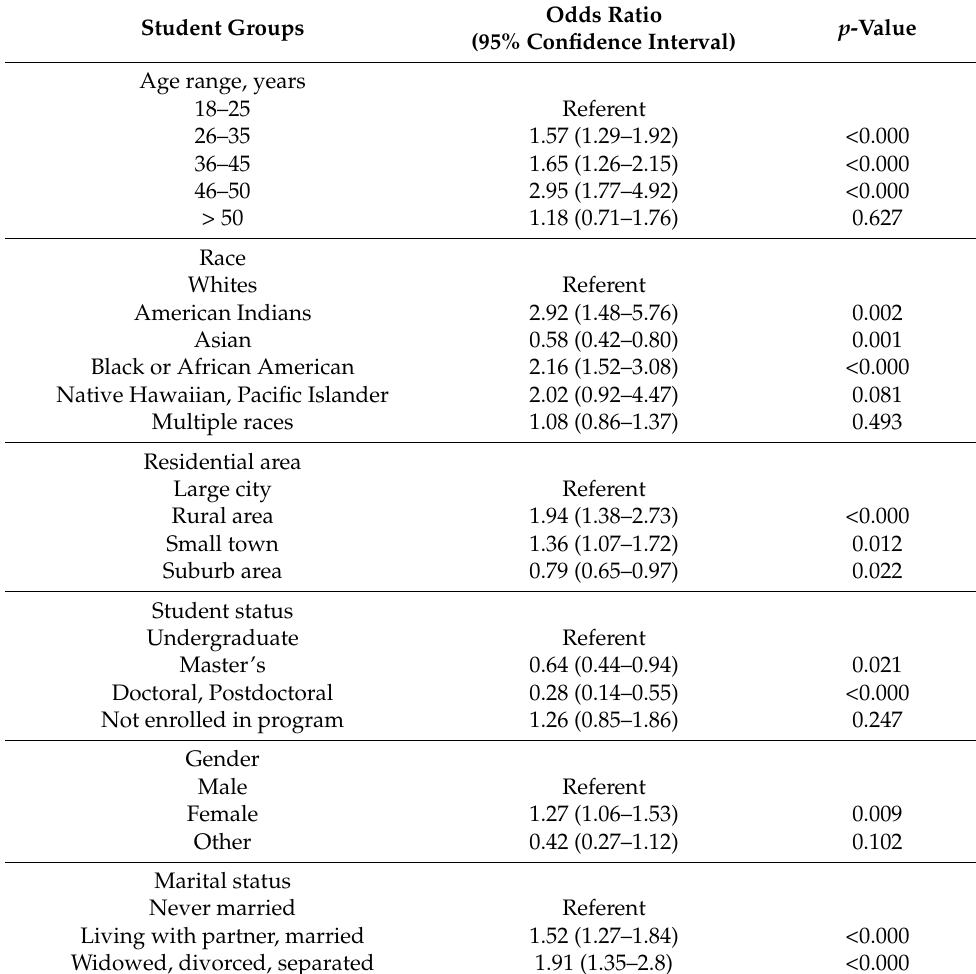
Table 3. Vaccine hesitancy among students in Nevada, February–March,